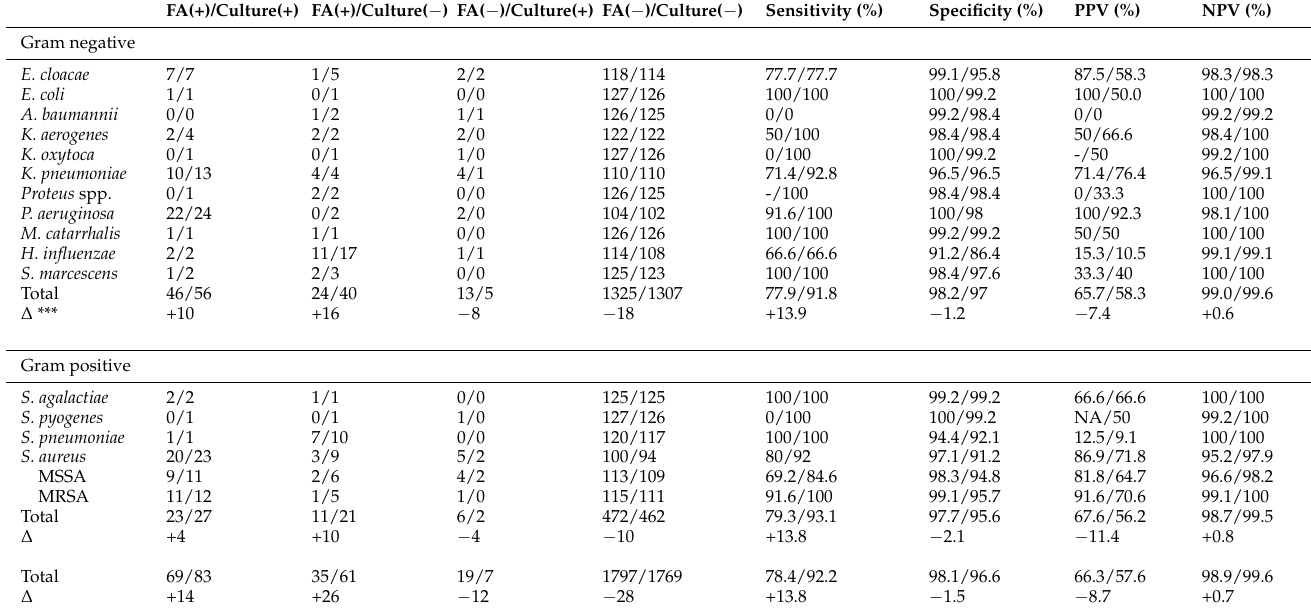
Table 4. Analytical performance of FA compared to culture using a strict and less strict sets of rules (Strict */Less strict